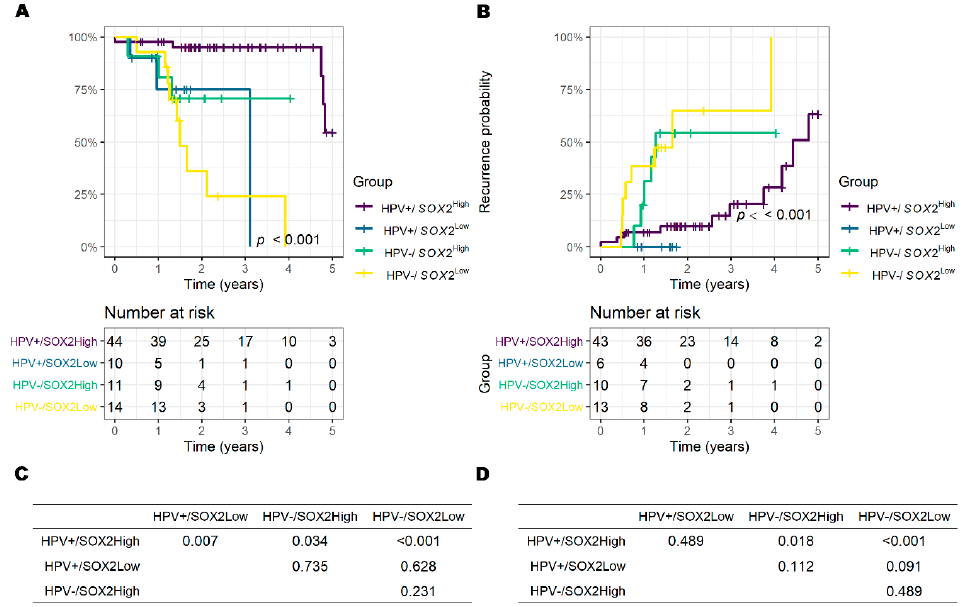
Figure 6. Survival and recurrence in four groups classified by HPV +/ − and SOX2 High / Low in TCGA dataset. ( A ) The 5-year overall survival (OS) and number at risk table. ( B ) The 5-year recurrence and number at risk table. Pairwise log-rank test as a post hoc analysis for 5-year OS ( C ) and recurrence ( D ).